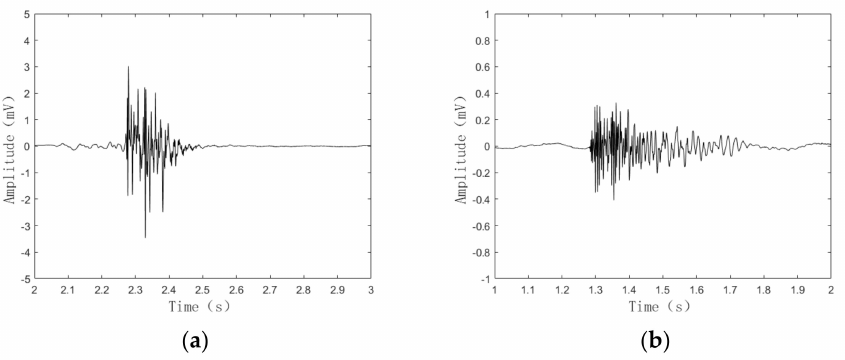
Figure 1. Measured signals received by VLA at ( a ) 2.9 km and ( b ) 19.6 km, which indicates the waveform expansion.